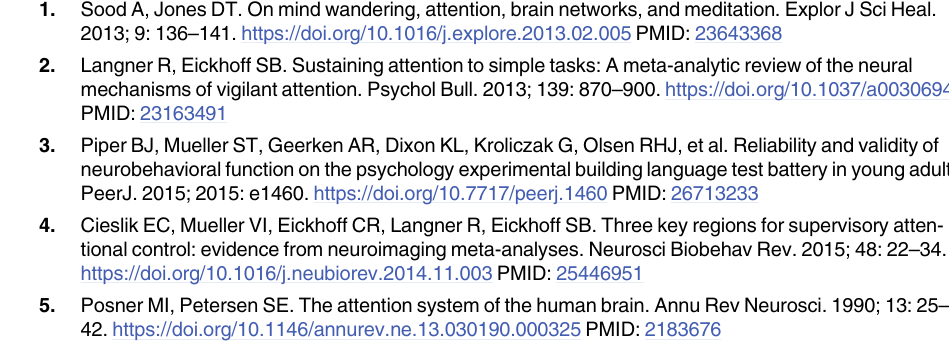
S9 Table. Significant correlations between task scores and questionnaire